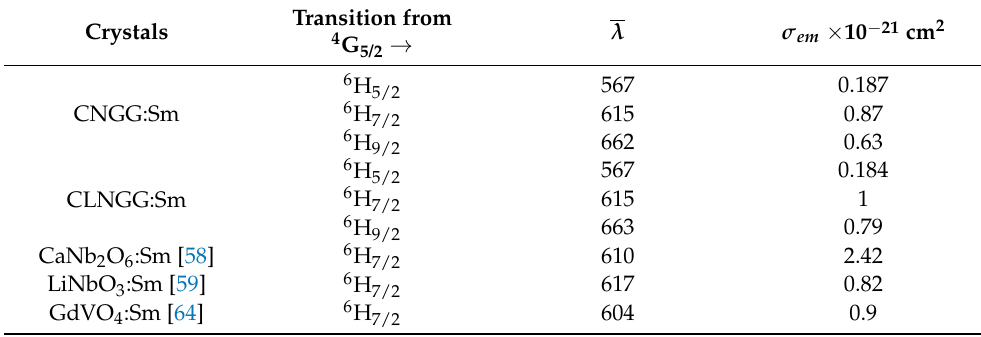
Table 4. Emission cross-sections of Sm 3+ ions in CNGG:Sm and CLNGG:Sm crystals compared to other similar crystals. (Reprinted with permission from Ref. [21], copyright 2017, Elsevier).